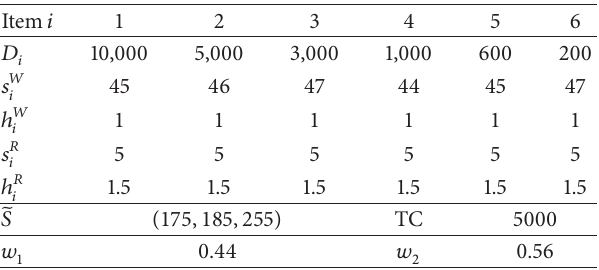
Table 1: Data for Experiment